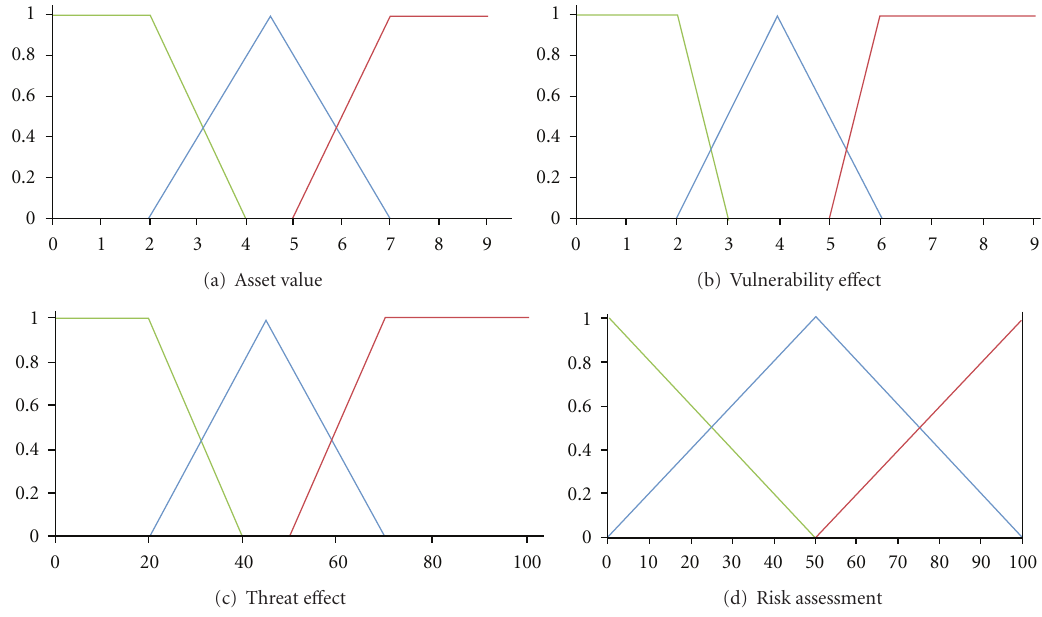
Figure 7: Three-level membership